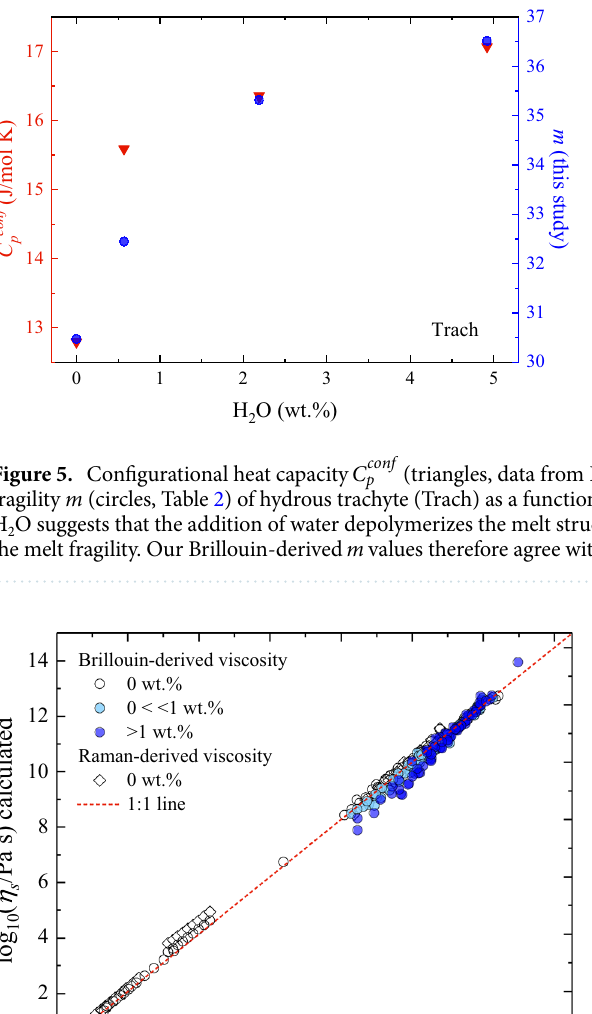
Figure 6. Comparison between measured viscosity values with Brillouin-derived (circles) and Raman-derived (empty diamonds) values. For the Brillouin-derived viscosity, both anhydrous (empty circles) and hydrous (coloured circles) data are reported. Hydrous data are grouped according to their water content (< 1 and > 1 wt%). The largest deviation between the measured and calculated values is observed for samples characterized by both the highest water content and lowest measured viscosity (see text for details). Only anhydrous viscosity is available for the Raman-derived